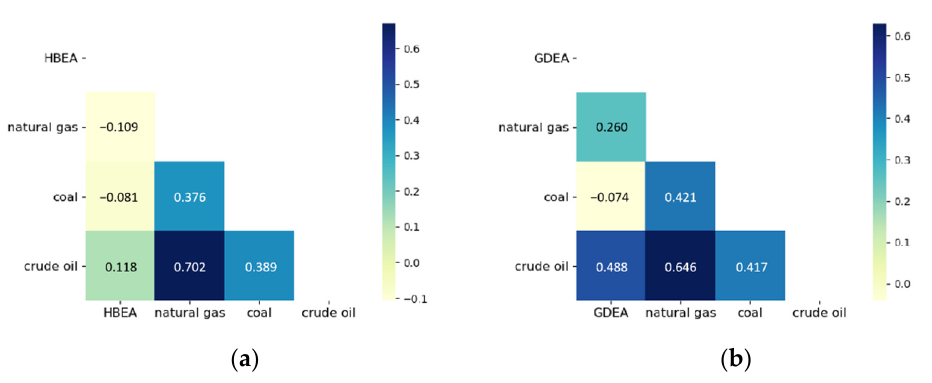
Figure 5. Pearson Heat Map. ( a ) HBEA; ( b ) GDEA.